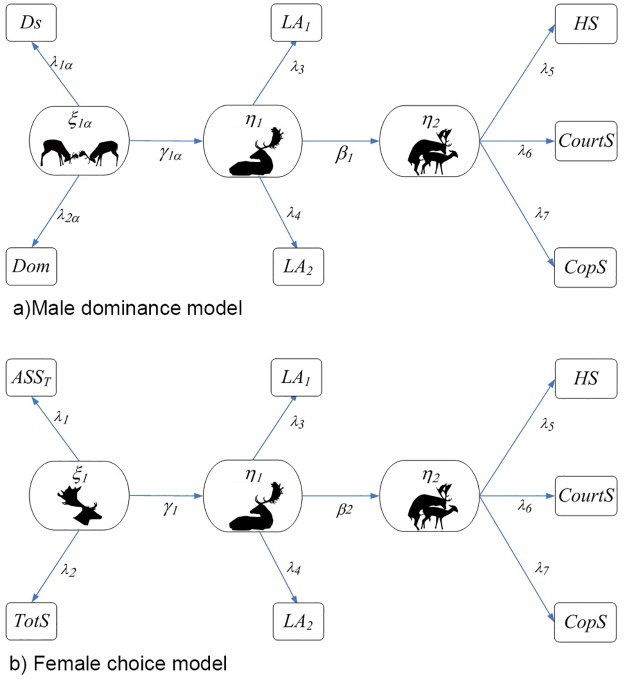
Path diagrams for a) the “dominance male” model (MDH) and b) “female choice” model (FCH).Variable names are: ASST = the fluctuating asymmetry of small antler’s spellers; TotS = total number of small and large antler’s spellers; Dom = Dominance Index (Clutton-Brock Index [55]) divided by the total number of bucks of each year; Ds = the David’s score (Gammel et al.) [56] divided for the total number of bucks of each year; LA1 = number of days in which the animal was present in the lek. LA2 = total number of days of presence/territory in different locations of the same lek. HS = average number of females in a male’s territory; CourtS = the fraction of courtship events terminated with a copulation (number of copulations / number of courtship events, for every male); CopS = total copulatory success of the i-th buck in one rut. The number of observations is the same for all models (N = 118). Symbols and variables are described in the text and in S1 Table.